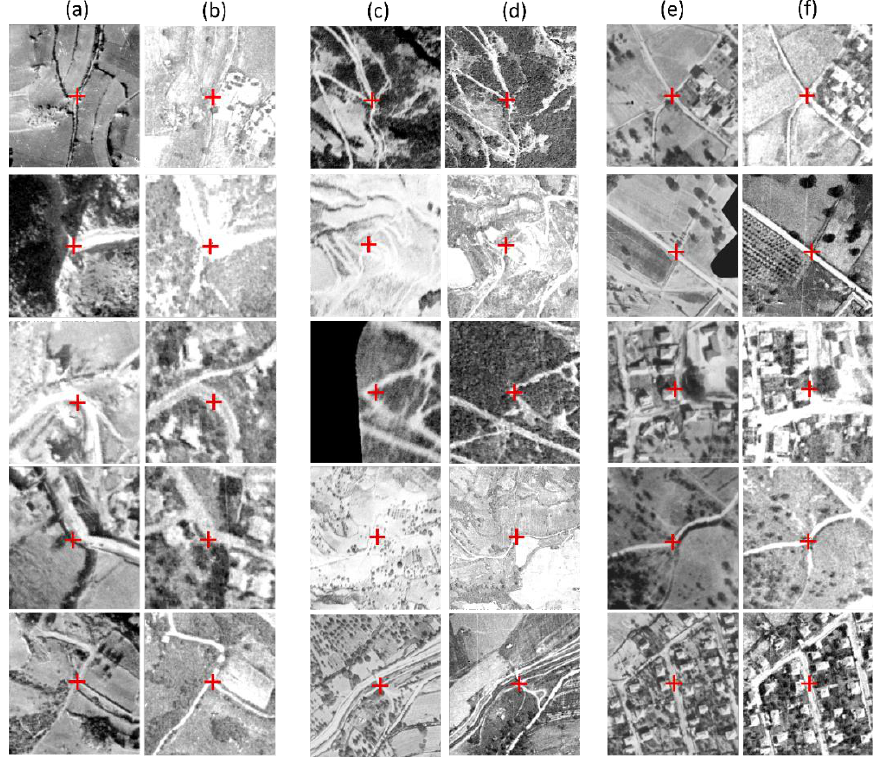
Figure 4. Examples of GCPs selection (red crosses) on ( a , c , e ) aerial photographs from 1952 and 1965, and their counterparts on ( b , d , f ) rectified 1975 Ruen aerial photograph.